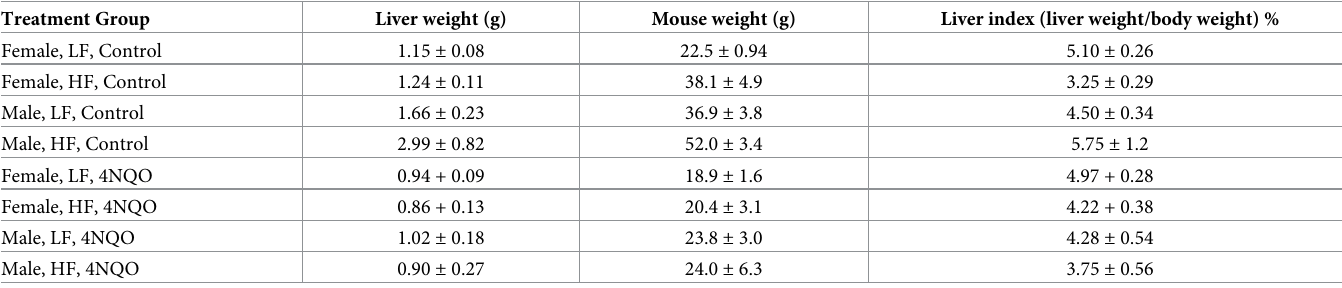
Table 1. Comparison of liver weight and liver index among treatment groups. Treatment